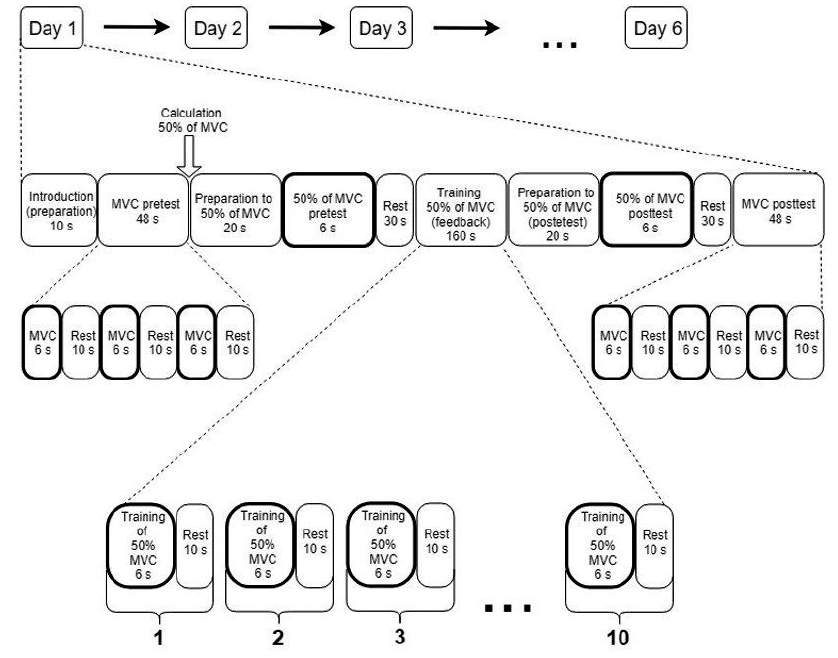
Figure 1. The experimental protocol of the training program performed each day by all the groups. MVC: maximum voluntary contraction.